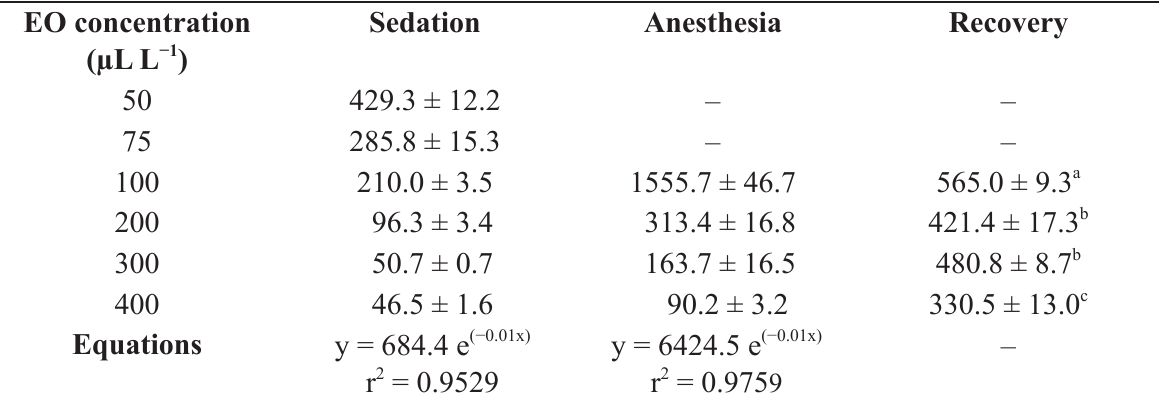
Time (in seconds) required for induction and recovery from anesthesia using the essential oil of Aloysia polystachya leaves (EO) in Epinephelus marginatus.